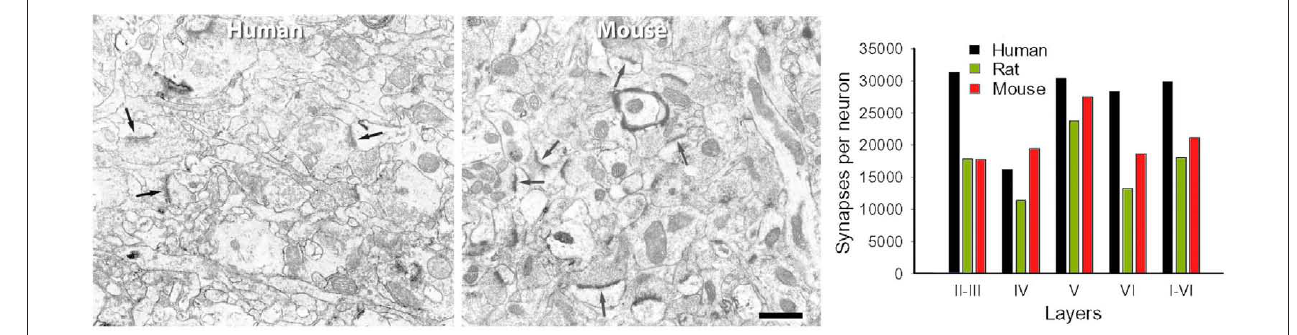
bar = 0.5 μm. Right, Number of synapses per neuron in the human, rat, and mouse. The values obtained in layers II, IIIa, and IIIb of human, and layers Va and Vb of rat